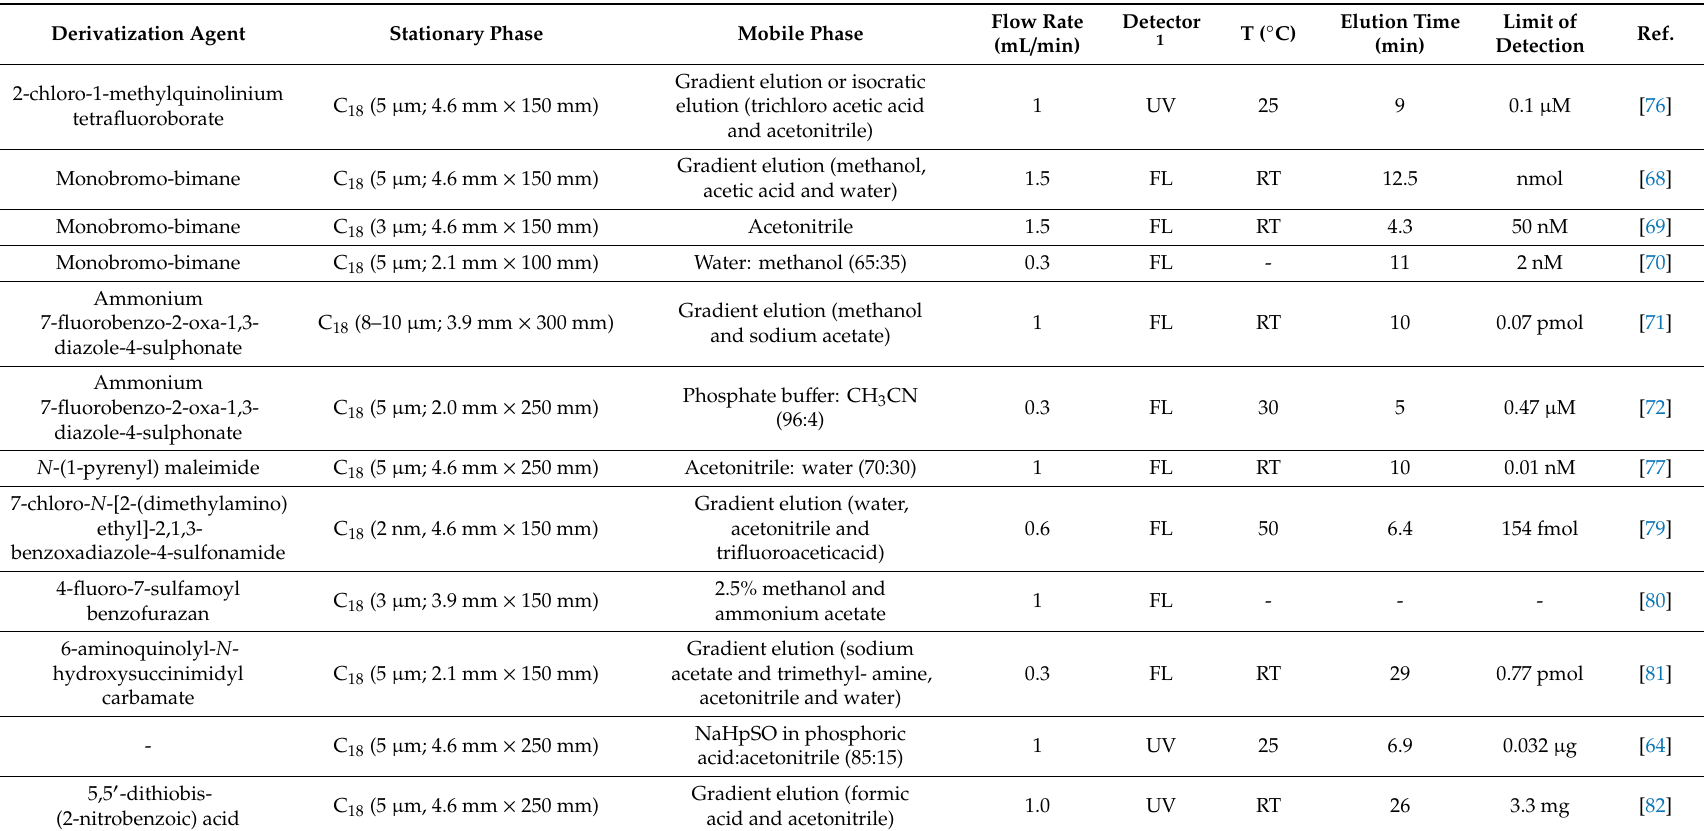
Table 3. HPLC detection methods for